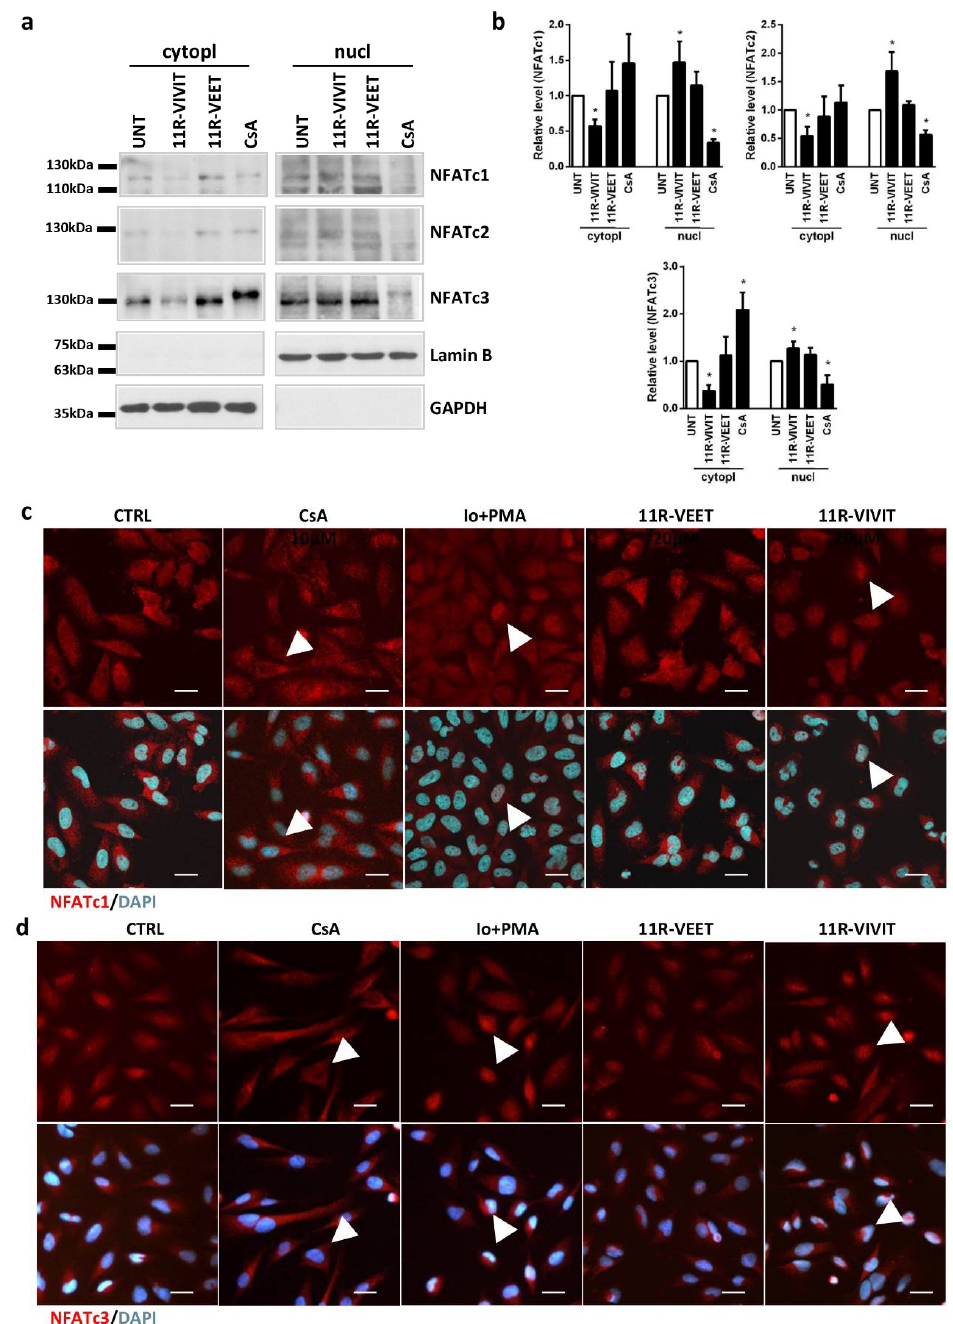
Figure 5. 11R-VIVIT enhances NFAT translocation to the nucleus. ( a ) Distribution of NFATc1–c3 in cytosolic and nuclear fractions was evaluated using Western blotting 4 h after treatment of LN229 cells with 11R-VIVIT (20 µM), 11R-VEET (20 µM) or CsA (5 µg/mL). ( b ) The graphs show the relative intensity of the bands on immunoblots as compared to the control (UNT). The levels were based on the densitometric evaluation and normalized to GAPDH or Lamin B levels for cytosolic or nuclear fractions, respectively (the mean +/− SD of three independent experiments). Statistical significance of changes was determined using one-sample t -test (* p < 0.05), ( c , d ) Subcellular localization of NFATc1 ( c ) and NFATc3 ( d ) in LN229 cells 4 h after treatment with 11R-VIVIT, 11R-VEET (both at 20 µM), 1 µM Io/50 nM PMA or CsA (5 µg/mL). A scale bar corresponds to 25 µm.